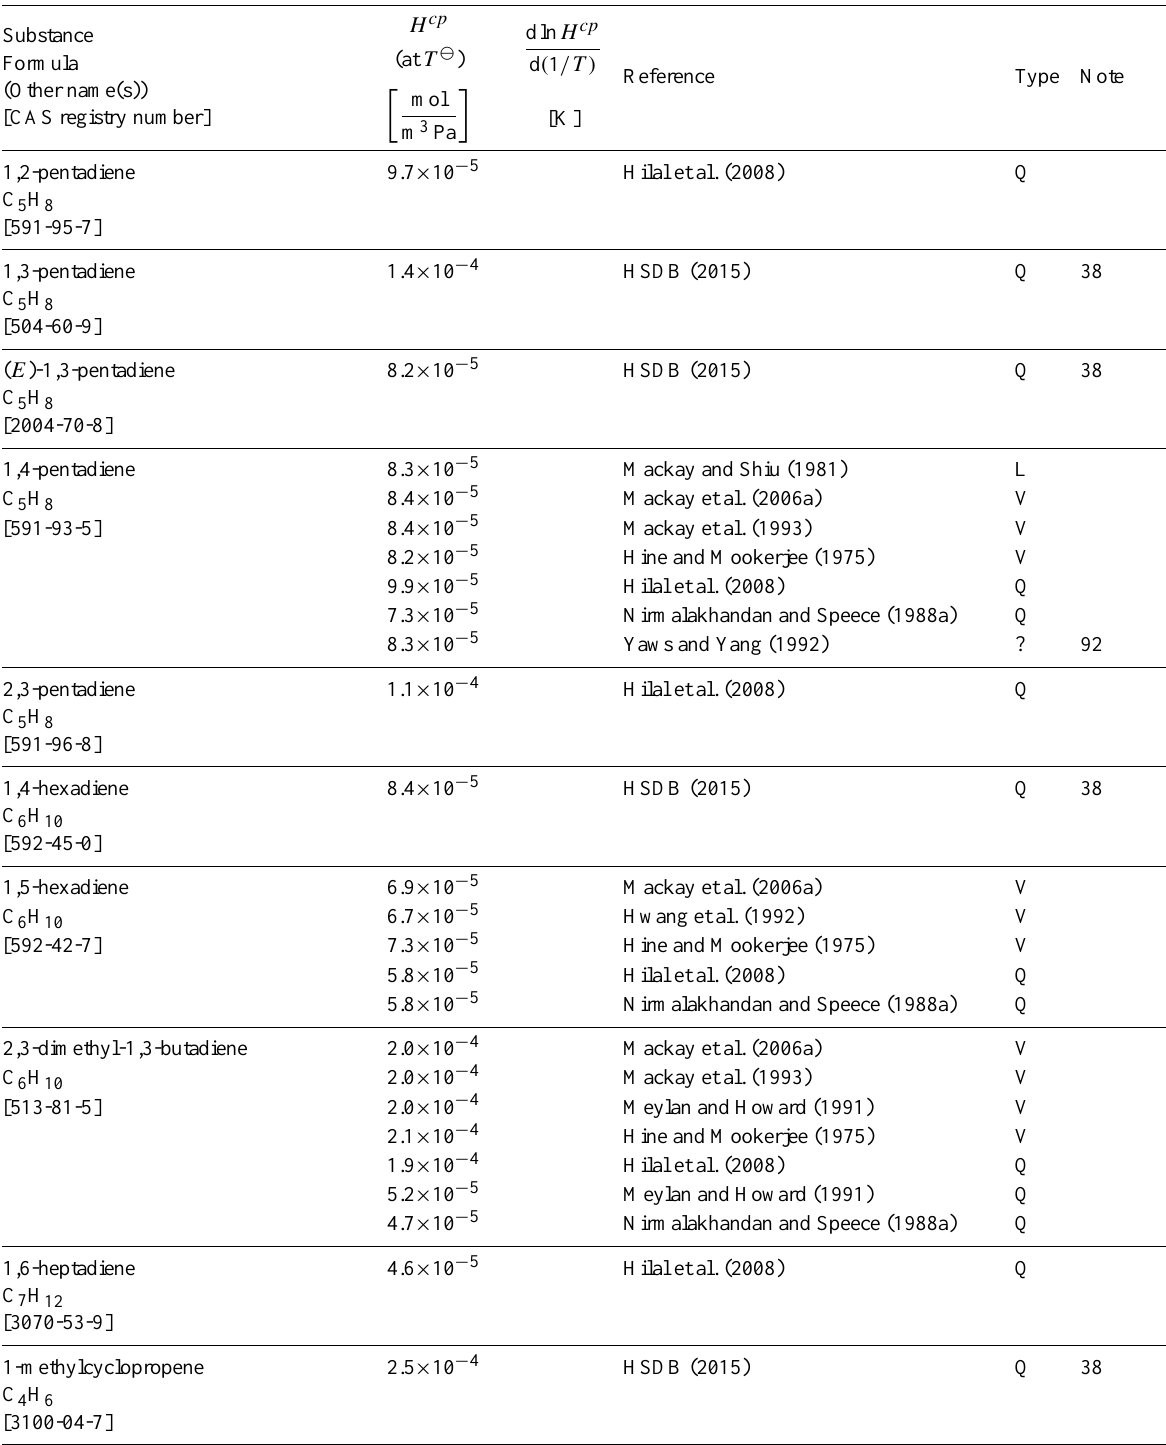
Table 6: Henry’s law constants for water as solvent